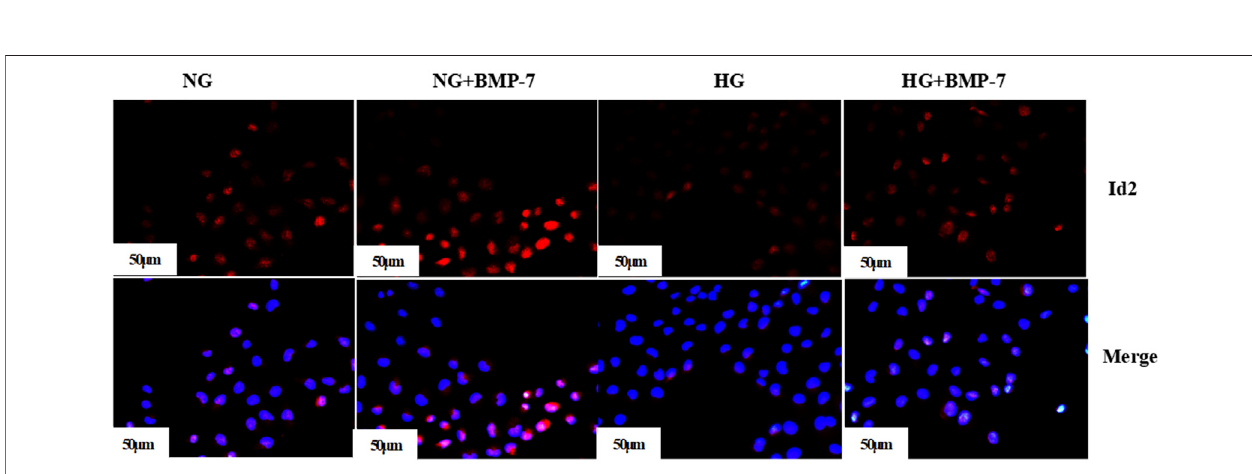
Frontiers in Pharmacology |